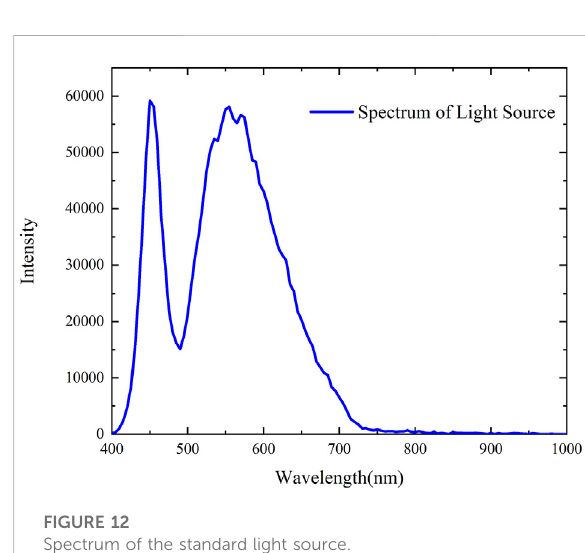
FIGURE 11 Spectrum of different color blocks.